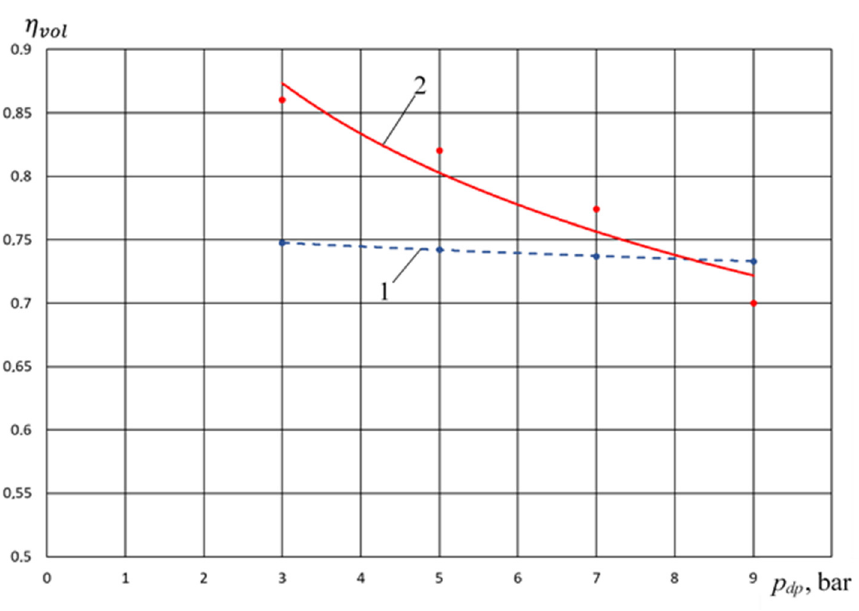
Figure 17. Volumetric efficiency of the pump section from the discharge pressure of the pump section (1—Theory; 2—Experiment).